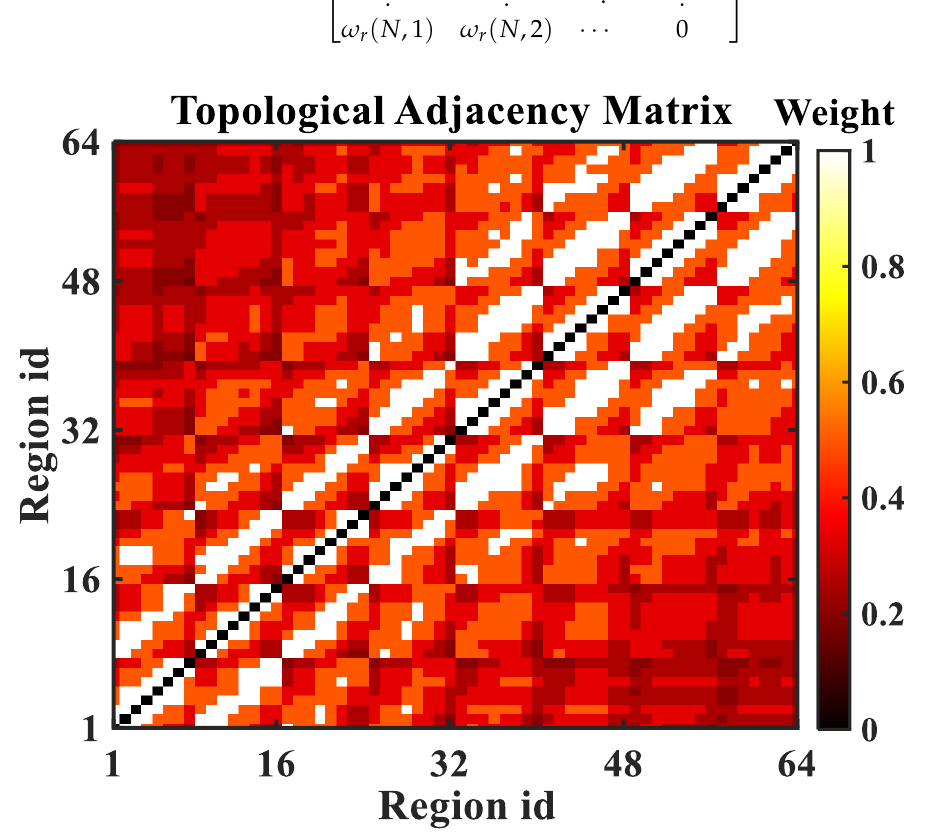
Figure 1. The topological adjacency